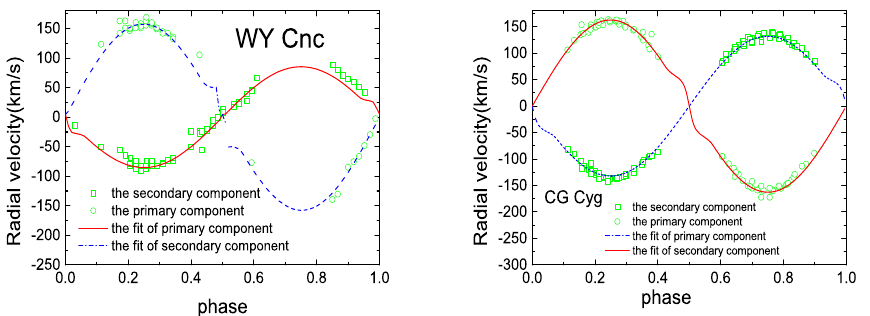
Figure 7. Theoretical and observational radial velocity curves, where the left panel is the radial velocity of WY Cnc, and right is CG